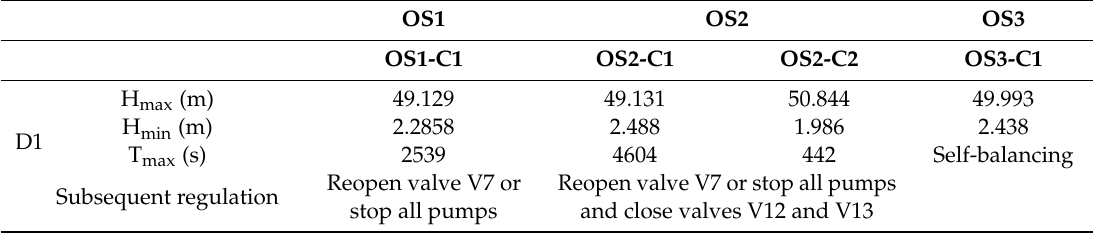
Table 4. The transient processes in three operating scenarios under condition